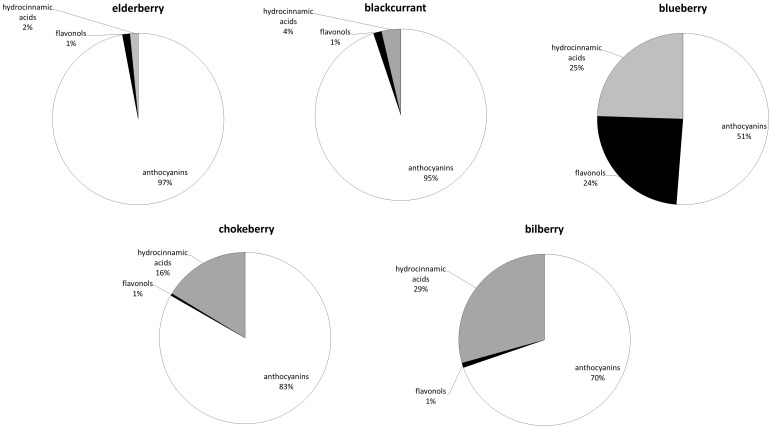
Distribution of total phenolic uptake according to particular phenolic groups.